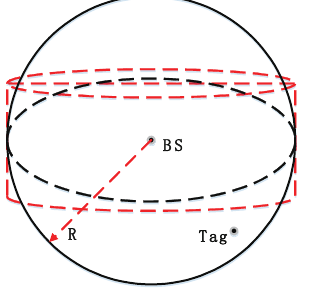
Figure 1. Single base-station signal coverage model.